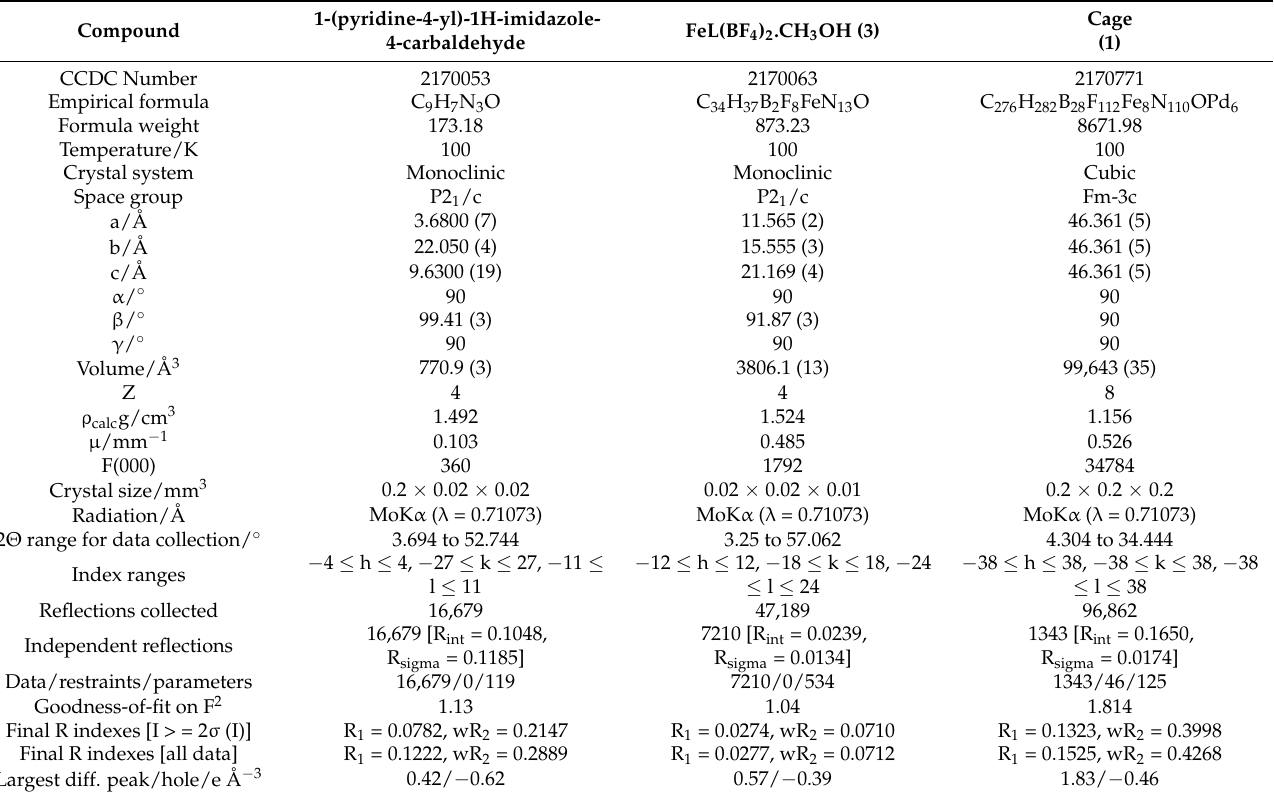
Table 1. Crystallographic data for 1-(pyridine-4-yl)-1H-imidazole-4-carbaldehyde, FeL(BF 4 ) 2 ( 3 ) and Heterobimetallic cage ( 1